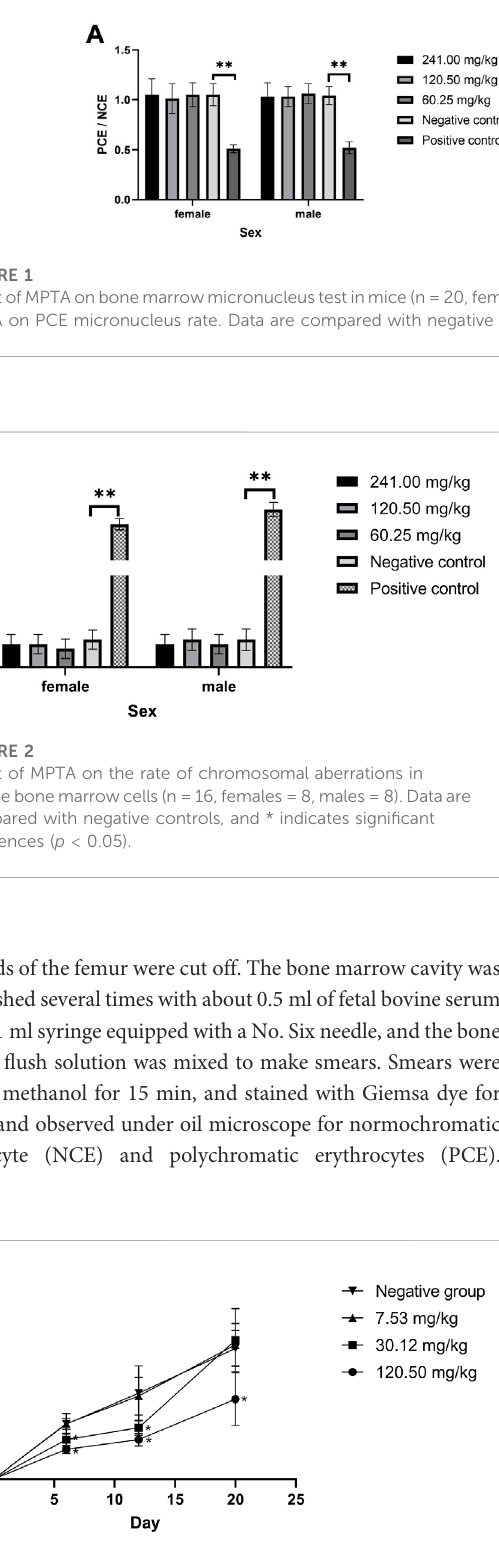
FIGURE 3 Effect of MPTA on body weight gain in pregnant